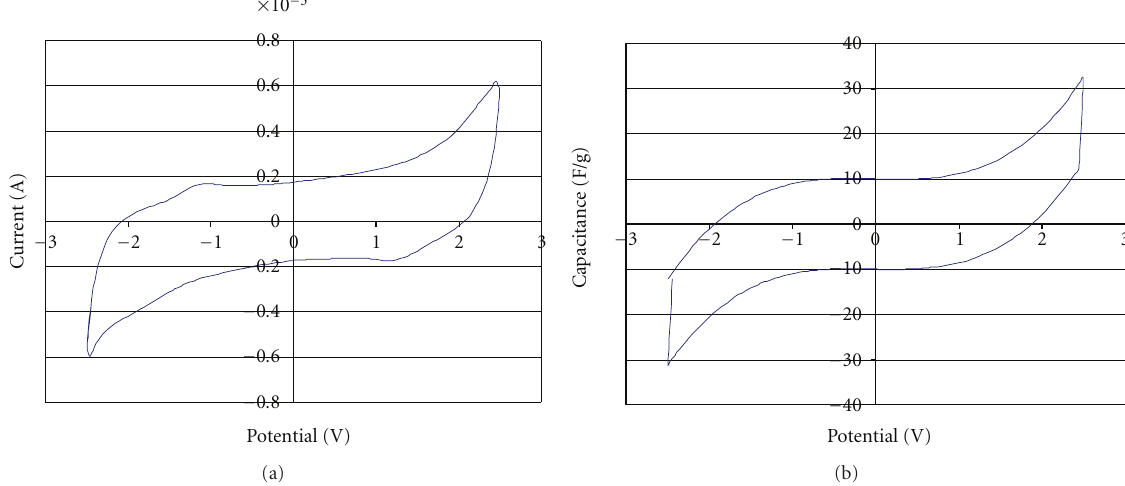
Figure 6: Cyclic voltametry of EDLC CNT-GF/F capacitor from 0 to 2.5V at a rate of 0.2V/s and specific capacitance of electrode; each CNT electrode has an area of 1 cm 2 and mass of 0.2mg.